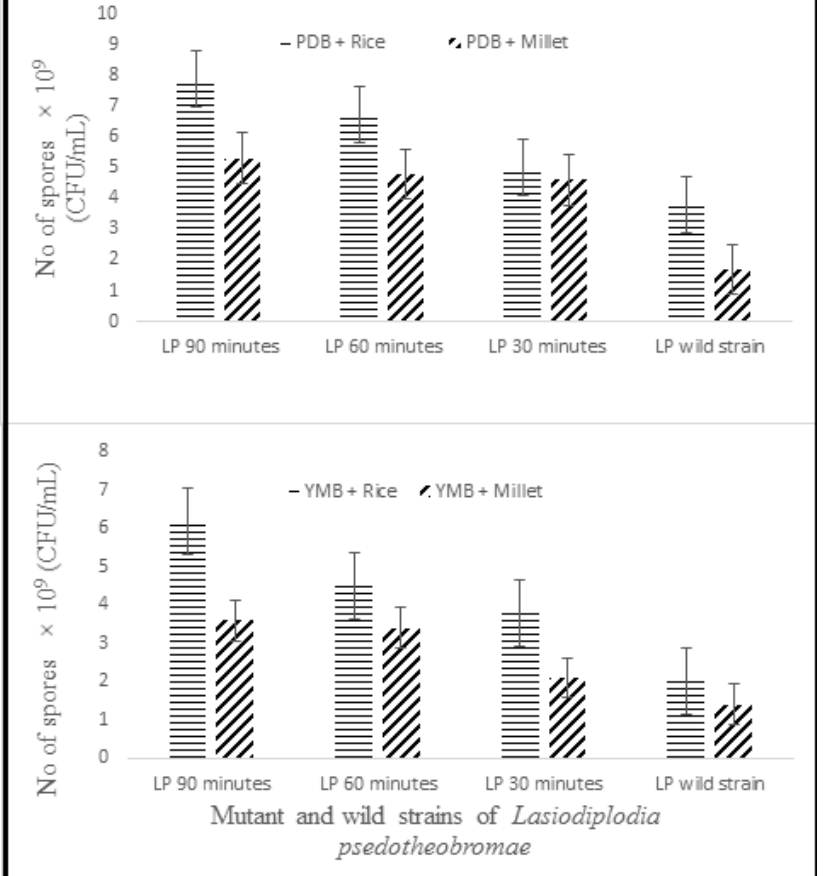
Fig. 3. Effect of biphasic system on the rate of sporulation from wild and mutant strain of C1136; (A) Number of spores produced from PDB + rice and PDB + millet by different strains of C1136; (B) Number of spores produced from YMB + rice and YMB + millet by different strains of